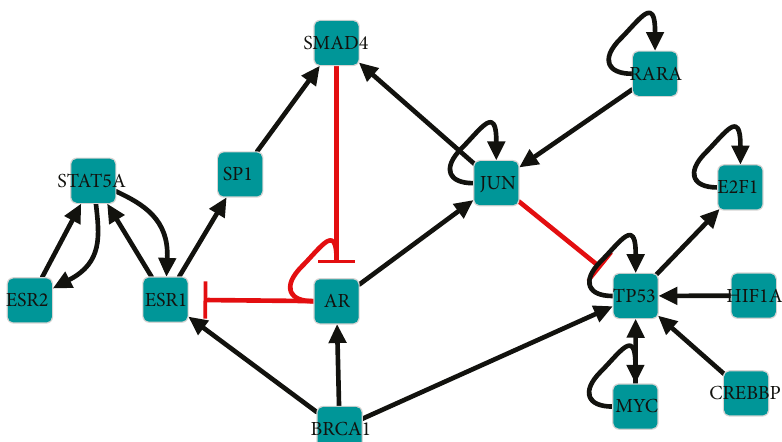
Figure 2: The estrogen receptor regulatory network. It was constructed from curated transcriptional interactions found in RegNetwork and IPA. Gene nodes include ESR1 and ESR2, the estrogen receptors. It has 25 interactions representing transcriptional regulation among these genes. Inhibitory regulation is represented in red; activatory regulation is depicted in